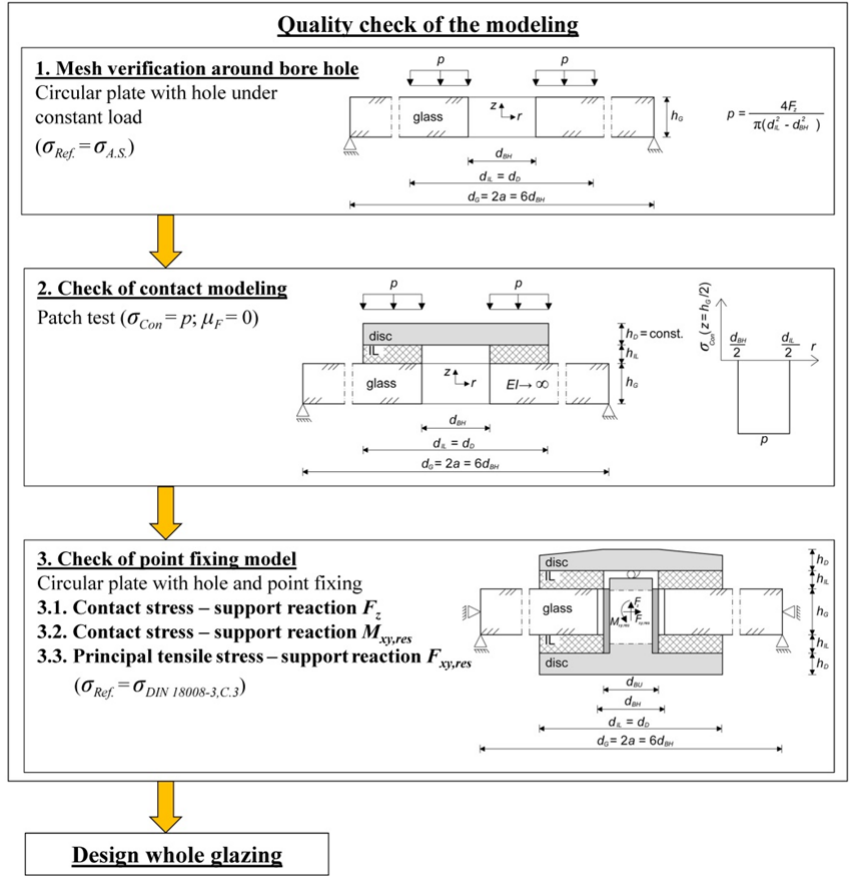
Fig. 2 Quality check of the modeling (overview) in accordance with Seel (2015).